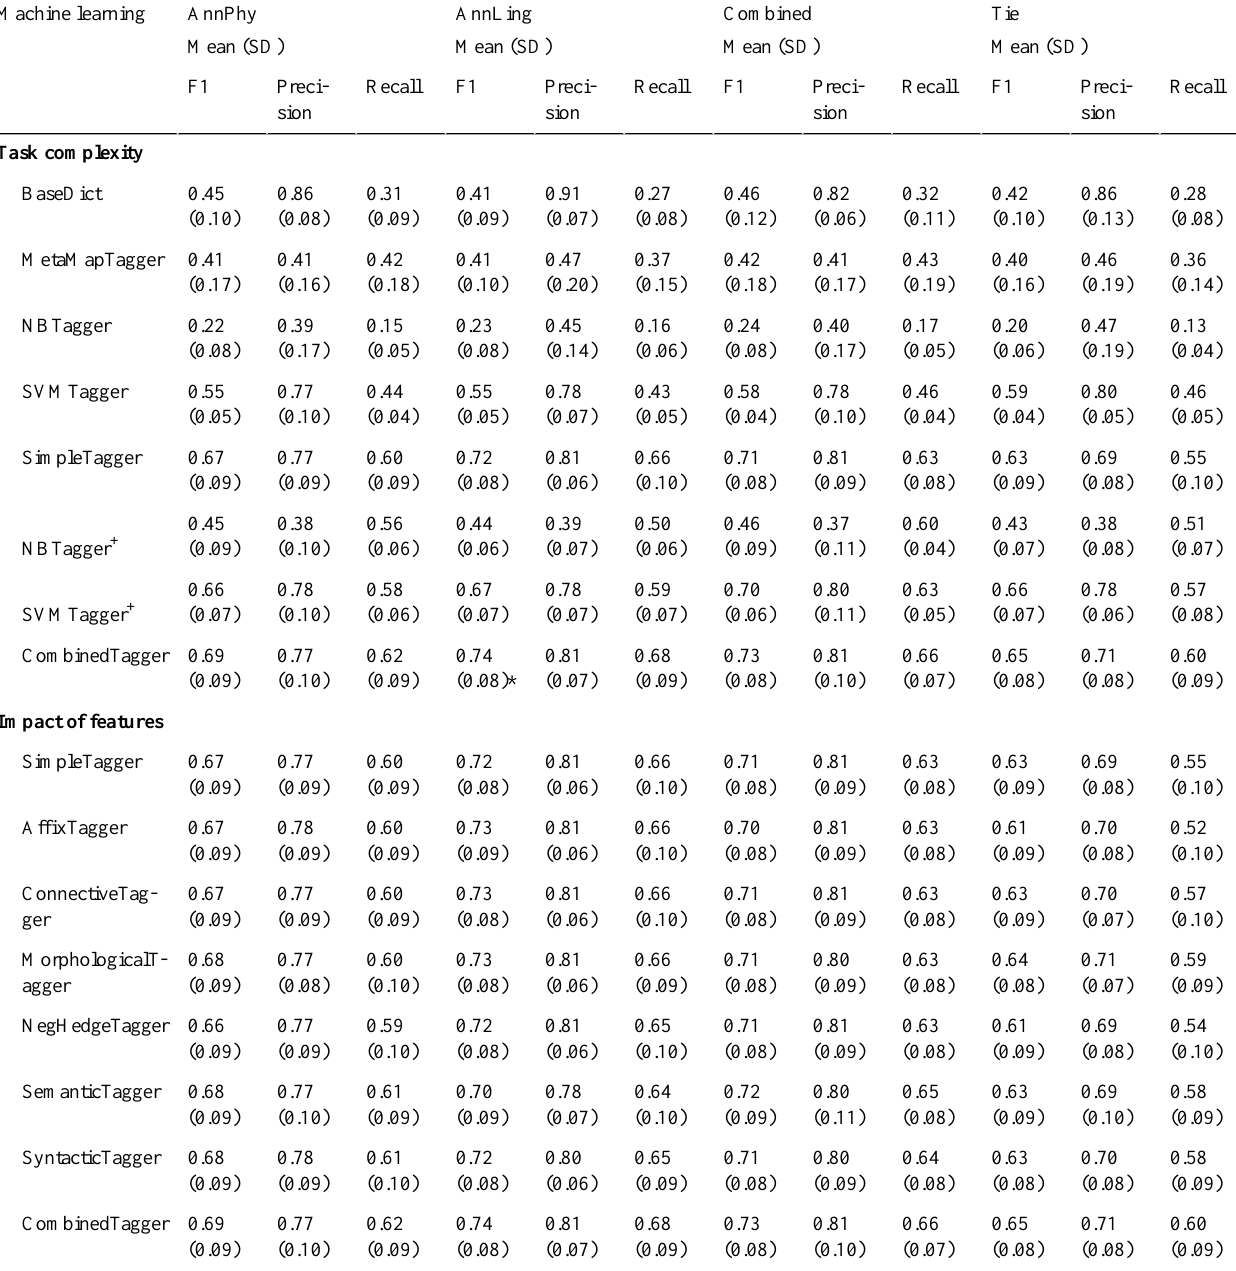
Table 2. The precision, recall, and F1 score of Taggers on each of the four annotated data sets ( t test, P